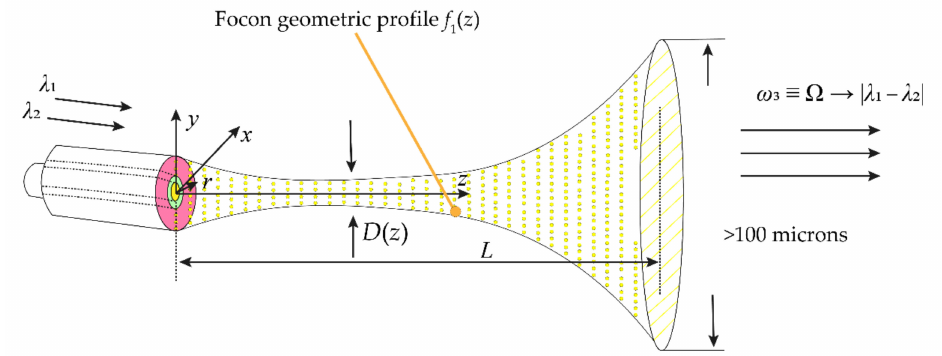
Figure 2. An illustration of the structure of the proposed radio-photonic conversion device that provides the generation of differential radio signal when optical radiation is supplied to the input at two close